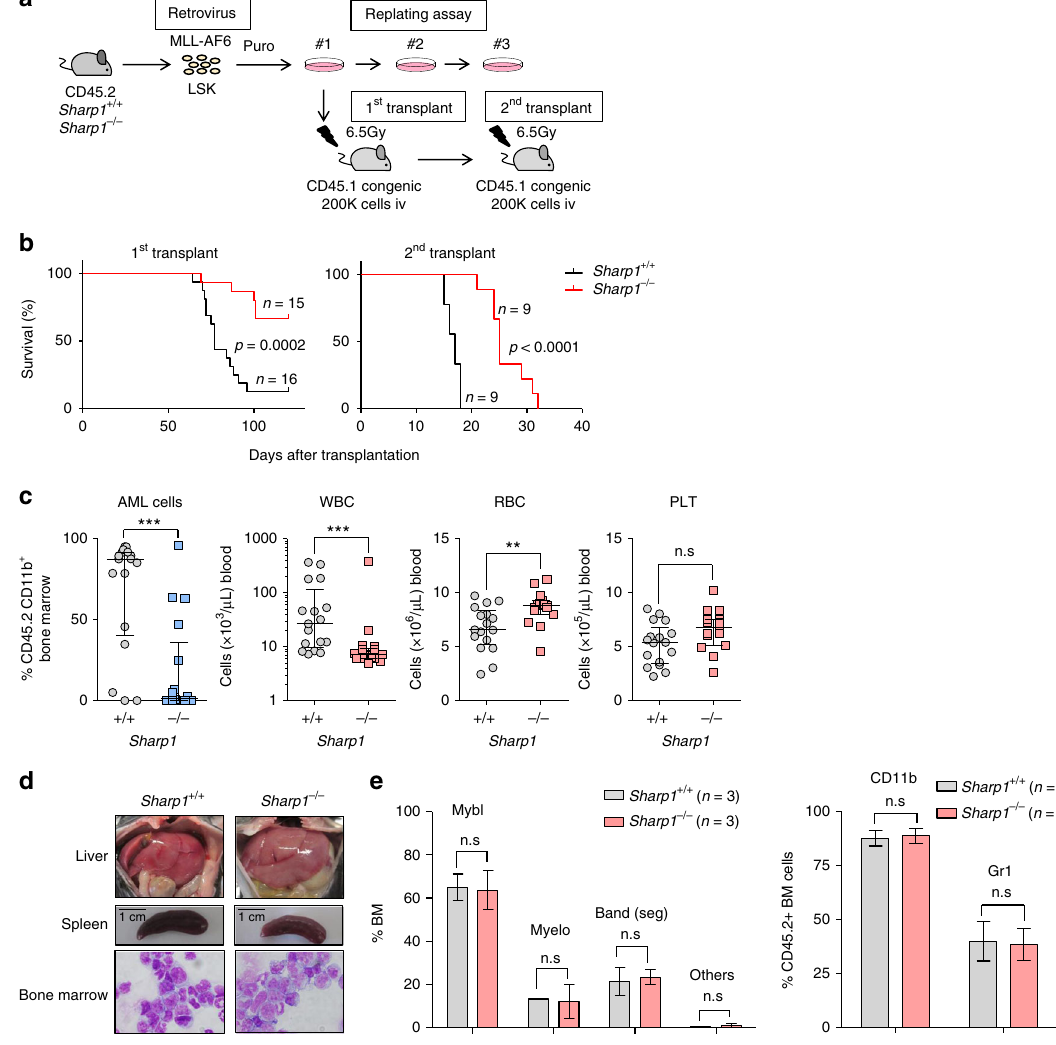
Fig. 4 Sharp1 deletion attenuates MLL-AF6 AML progression. a Experimental strategy for replating and in vivo leukemia assays in Sharp1 + / + or Sharp1 − / − hematopoietic stem/progenitor cells following retroviral transduction of MLL-AF6. b Kaplan – Meyer survival curve of sublethally irradiated congenic mice transplanted with 200,000 cells from (left panel) the fi rst replate (right panel) and whole bone marrow cells isolated from leukemic recipients following the fi rst transplant. Data includes at least two independent transplantation experiments. Statistical analysis was performed using Log-rank (Mantle-Cox) test. c Peripheral blood count and percentage of leukemia cells (CD45.2 + CD11b + ) from the recipient mice ( n = 17 per genotype) two months after primary transplant are shown. Statistical analysis was performed using Mann – Whitney U test, ** p < 0.01, *** p < 0.001. All individual data points include three independent transplantation experiments and are presented as mean ± s.e.m. d Representative pictures of liver and spleen and Wright Giemsa staining of bone marrow (BM) cells from moribund leukemic mice. e Left panel: Differential count of Wright Giemsa-stained BM cells from moribund leukemic mice. Mybl myeloblasts, Myelo promyelocytes, myelocytes, and metamyelocytes, Band (seg) band and segmented neutrophils, Others lymphocytes and macrophages. Right panel: Percentage of CD11b high and Gr1 high cells in CD45.2 + BM cells are shown. The graph is present as mean ± s.e.m from three